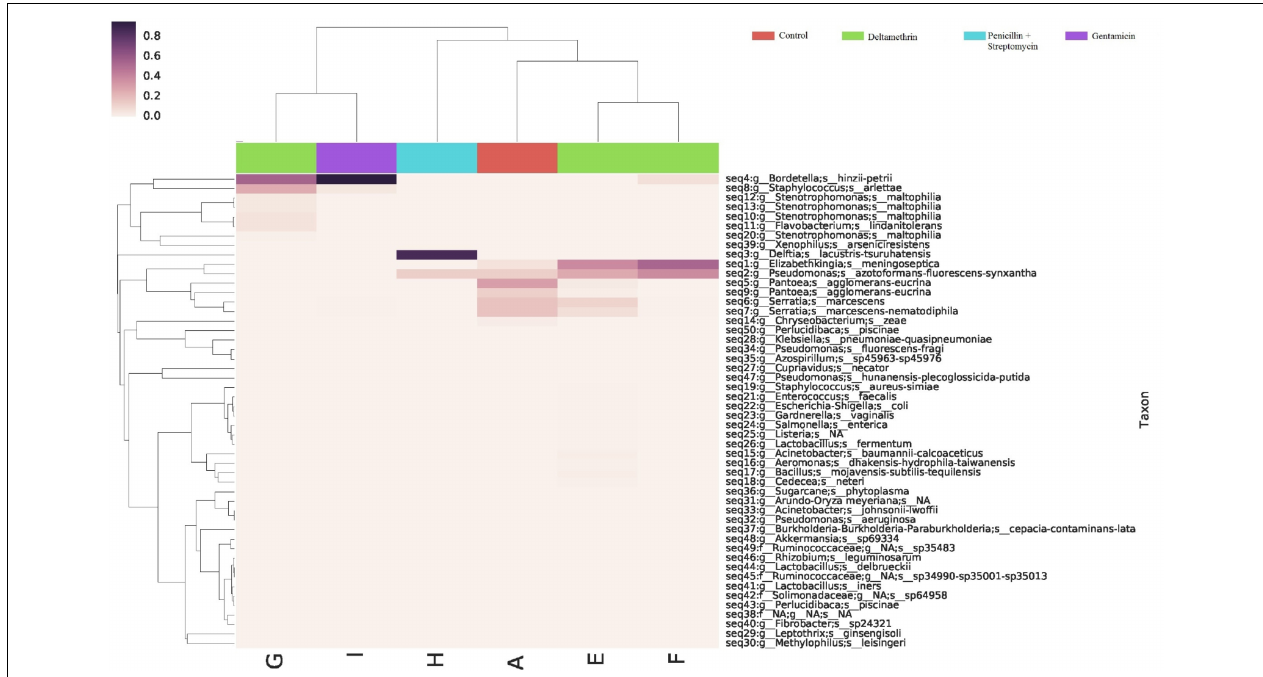
FIGURE 7 | Abundance heatmap of taxa with simple clustering (species) of bacterial communities of A. aegypti mosquitoes in deltamethrin exposure after microbiome suppression. A: fed with sucrose 10%, E: exposed to deltamethrin (control group), F: treated with penicillin/streptomycin deltamethrin exposed, G: treated with gentamicin deltamethrin exposed, H: treated with penicillin/streptomycin (not exposed), I: treated with gentamicin (not